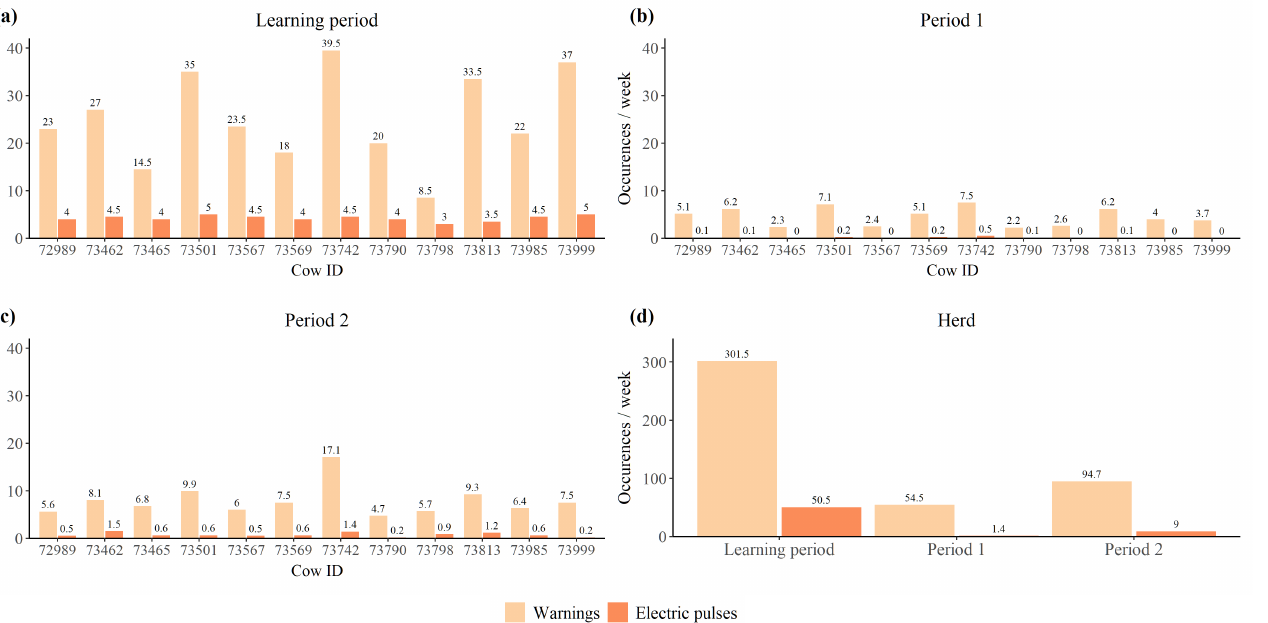
Figure 3. Average number of auditory warnings and electric impulses received per week by ( a ) each individual in the learning period , ( b ) each individual in period 1 , ( c ) each individual in period 2 , and ( d ) by the entire herd during each of the three